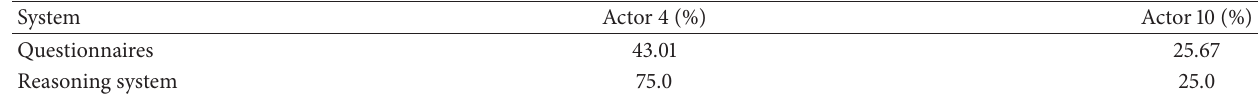
Table 4: Average of accuracy rates obtained by questioned people and system.